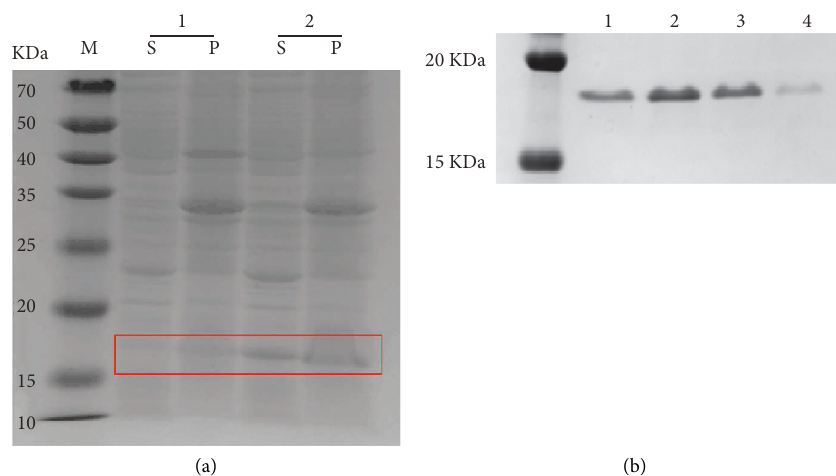
Figure 2: (a) Western blot analysis of BslA proteins. M, protein marker; S, supernatant; P, precipitate; 1, E. coli Rosetta with pET-28a-BslA, 30 ° C, 180rpm, 4 h; 2, E. coli Rosetta with pET-28a-BslA, IPTG, 30 ° C, 180rpm, 4h. (b) Elution effect of BslA on Ni-NTA purification. (1–4) The eluent of the first column volume to the eluent of the fourth column